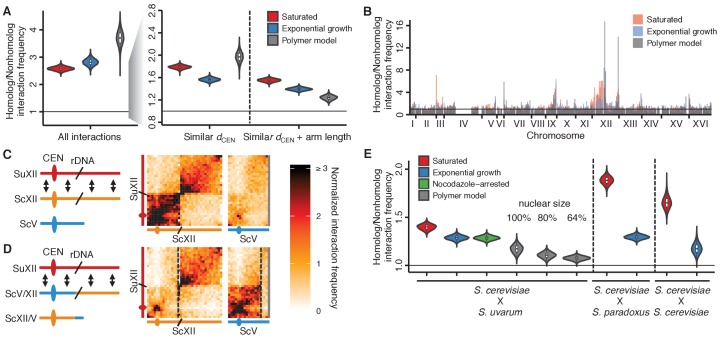
Homolog proximity exceeds predicted effects of Rabl-like orientation.(A) Violin plot of the distribution of 10,000 sampled estimates of genomic homolog proximity (ratio of homologous to nonhomologous interaction frequencies) in the S. cerevisiae x S. uvarum hybrid, as a function of increasing comparison stringency (left to right) to account for Rabl-like orientation (Figure 2—figure supplement 1). Saturated culture data are shown in red, exponential growth in blue, and simulated data from a homology-agnostic polymer model in grey. dCEN, distance from centromere. Boxplot indicates median and interquartile range. Whiskers correspond to the highest and lowest points within 1.5× interquartile range. (B) Variation in homolog proximity across the S. cerevisiae x S. uvarum hybrid genome at 32 kb resolution, in saturated culture (red), exponential growth (blue), and the polymer model (grey). Nonhomologous interactions were restricted to similar centromere distance and chromosome arm length. Bins with insufficient data (<2 comparisons) are left blank. Data are plotted by S. cerevisiae genome position. x ticks indicate ends of chromosomes. (C and D) Schematics and Hi-C contact maps (at 32 kb resolution) of interactions between S. uvarum chromosome XII (SuXII) and either S. cerevisiae chromosome XII (ScXII) or S. cerevisiae chromosome V (ScV), in wild-type S. cerevisiae x S. uvarum hybrids (C) and a strain with a translocation between ScXII and ScV (D), both in saturated cultures. Exponential growth data are shown in Figure 2—figure supplement 2. Ovals indicate centromeres and slanted lines indicate the locations of rDNA arrays. Double-headed arrows indicate enhanced interactions. Dashed lines indicate translocation breakpoints. (E) Violin plot of homolog proximity across conditions, polymer models, and hybrids. S. cerevisiae x S. cerevisiae indicates hybrid between Y12 and DBVPG6044 strains. Calculated as in (A), but excluding chromosome XII and all 32 kb bins that include centromeres. Saturated culture data are shown in red, exponential growth in blue, nocodazole-arrested in green, and polymer models in grey. Boxplot indicates median and interquartile range. Whiskers correspond to the highest and lowest points within the 1.5× interquartile range.